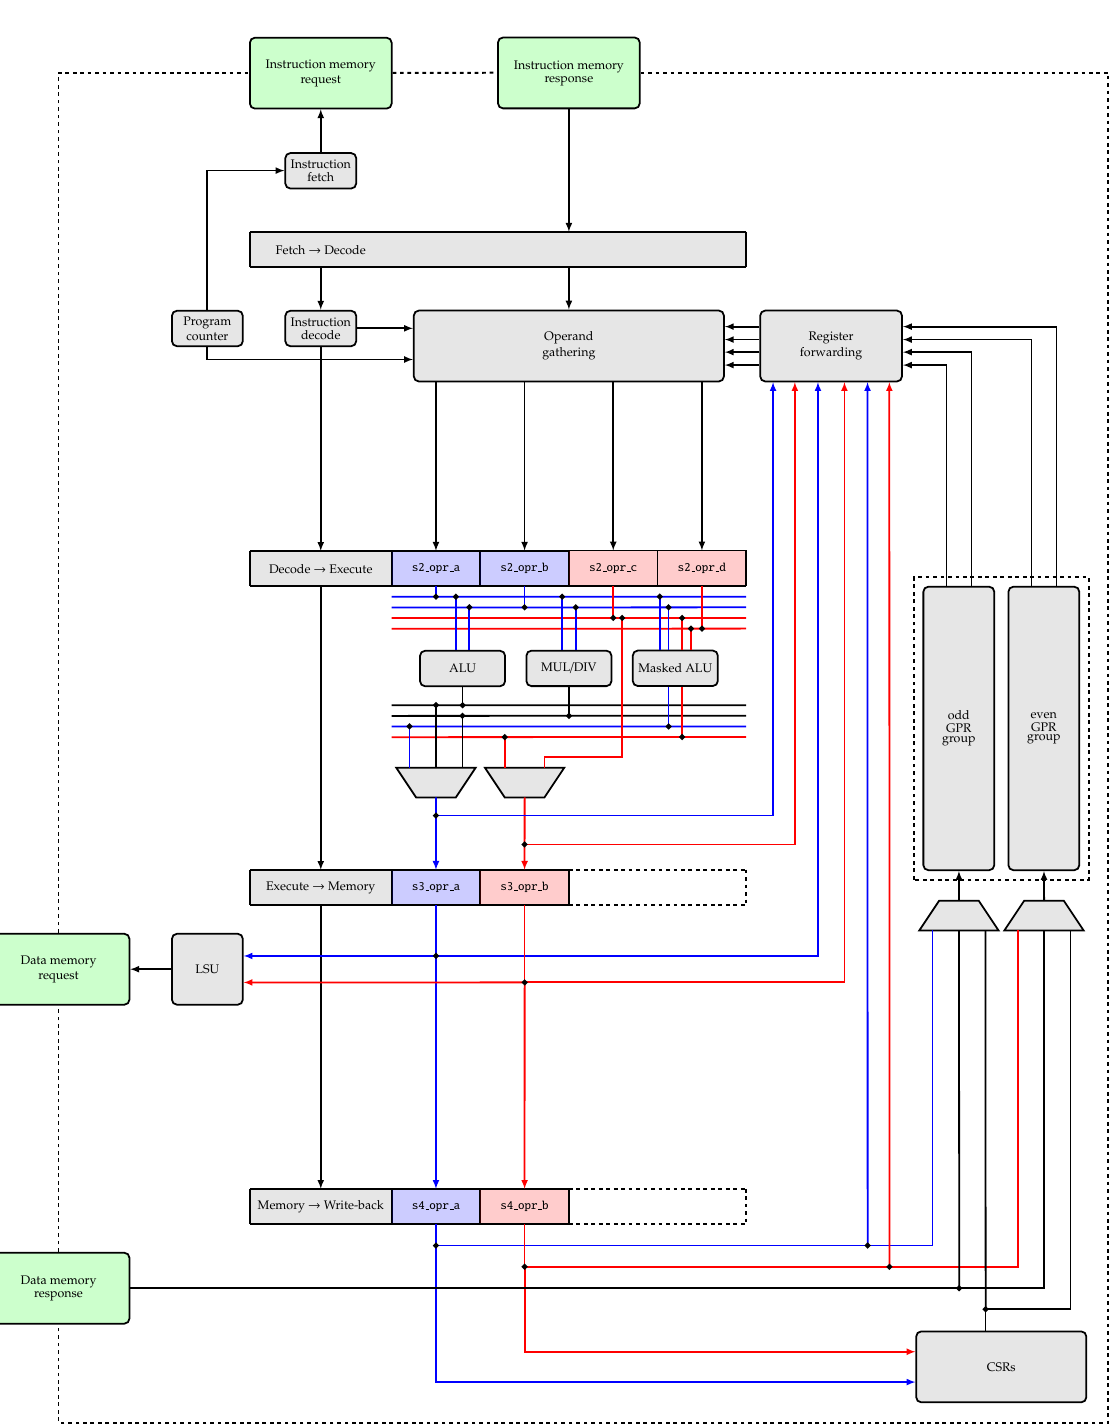
Figure 3: A block diagram illustrating integration of the masked ALU into the SCARV core. Note that registers and wires are coloured blue (resp. red) to reflect their relationship with the 0-th (resp. 1-st) share of intermediate, in-flight values; green modules represent the memory interface, careful use of which is important to ensure leakage-free transfer of shares between general-purpose registers and